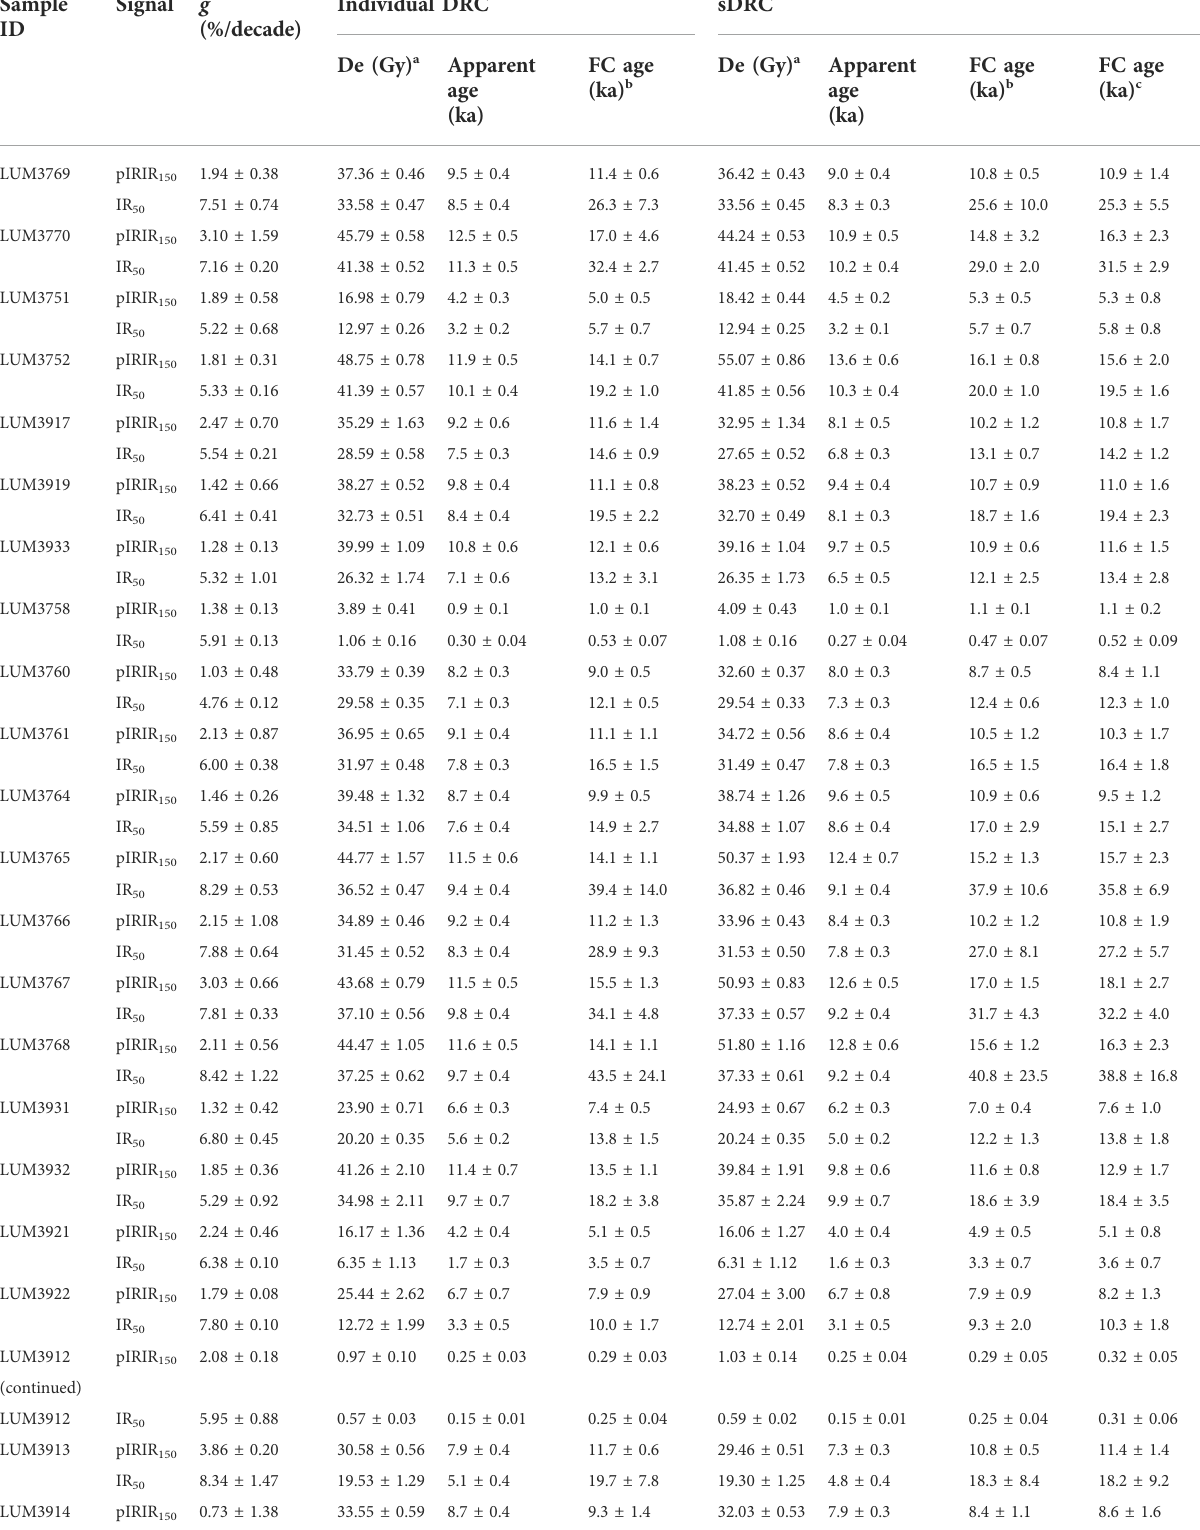
TABLE 3 Results of pIRIR 150 dating for all the